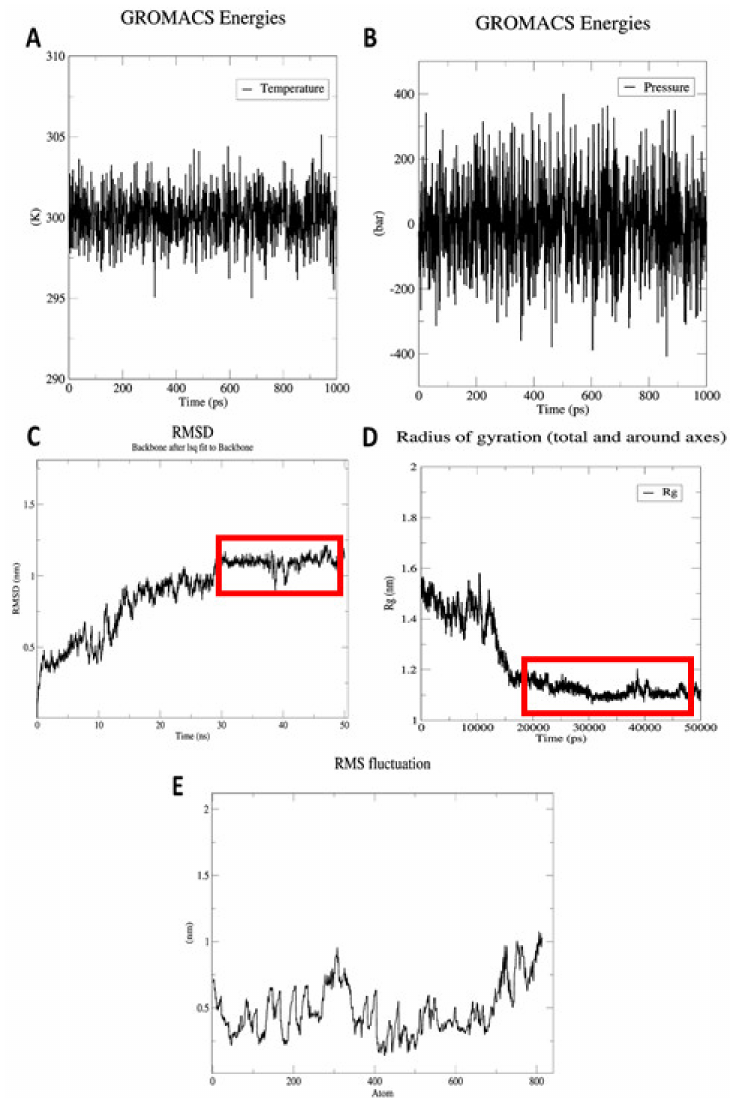
Figure 10. Graphs engendered throughout the MD simulation stages. ( A ) Temperature plot. System successfully achieves temperature of 300 K and showed least fluctuations afterwards. ( B ) Pressure plot. System maintains the pressure at 1.3 bar throughout 100 ps. ( C ) RoG plot. RoG is fairly stable after 20 ns, showing the vaccine in its compacted form during the simulation run. ( D ) RMSD plot. RMSD of the protein backbone reaches ~1.2 nm after 30 ns and is maintained generally afterwards, which represents the minimum structural deviations of a vaccine construct. ( E ) RMSF plot. Side chain’s RMSF plot displays peaks depicting high flexibility in certain areas of the designed